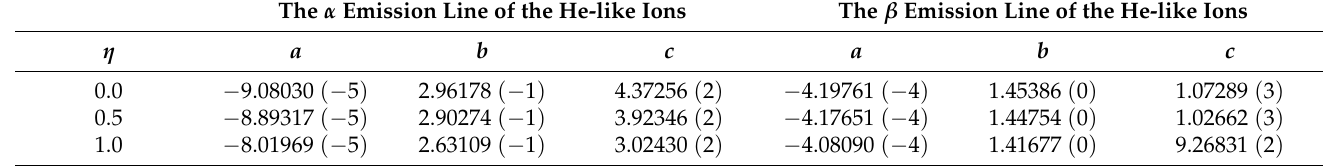
Table 1. Fit average coefficients a , b , and c in A ( e ) = A × 10 e for the α and β emission lines of the He-like ions with the size parameters η = 0, 0.5, and 1 (corresponding to the R in percentage). The α Emission Line of the He-like Ions The β Emission Line of the He-like Ions